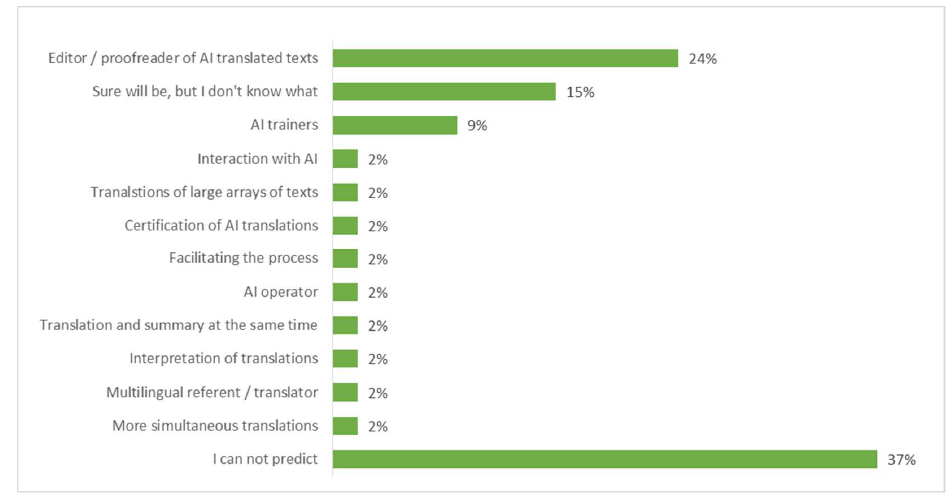
Figure 10. New activities unknown so far that might emerge. N = 59.